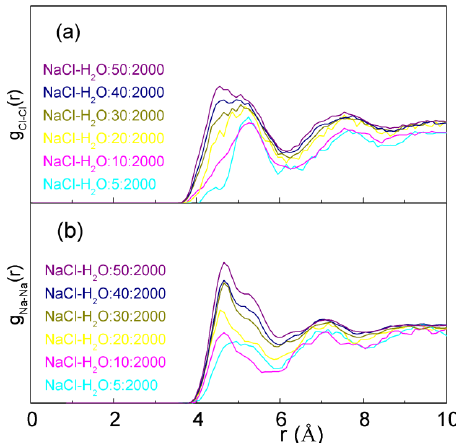
Figure 2. The calculated g Cl-Cl(r) ( a ) and g Na-Na(r) ( b )functions of NaCl solutions.